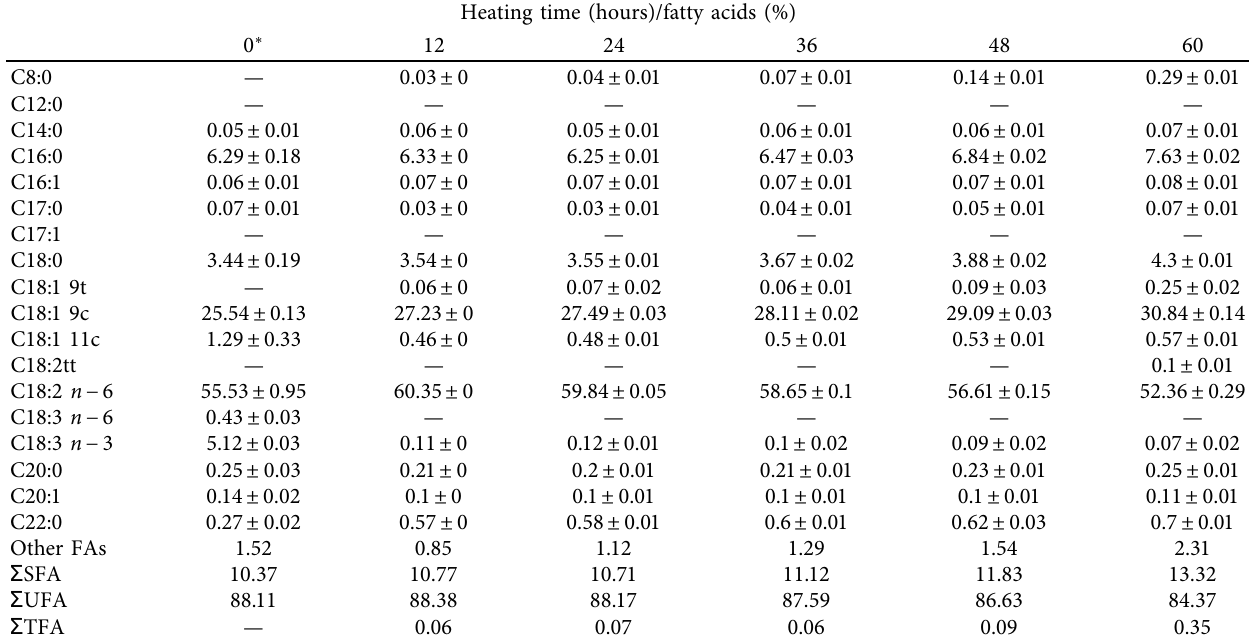
Table 9: Variation of fatty acids of sunflower oil under 210 ° C heating temperature at different heating times. Heating time (hours)/fatty acids (%)